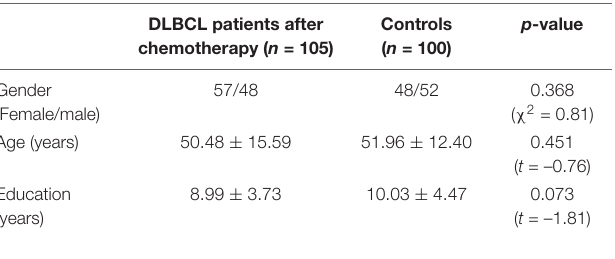
TABLE 1 | Demographic